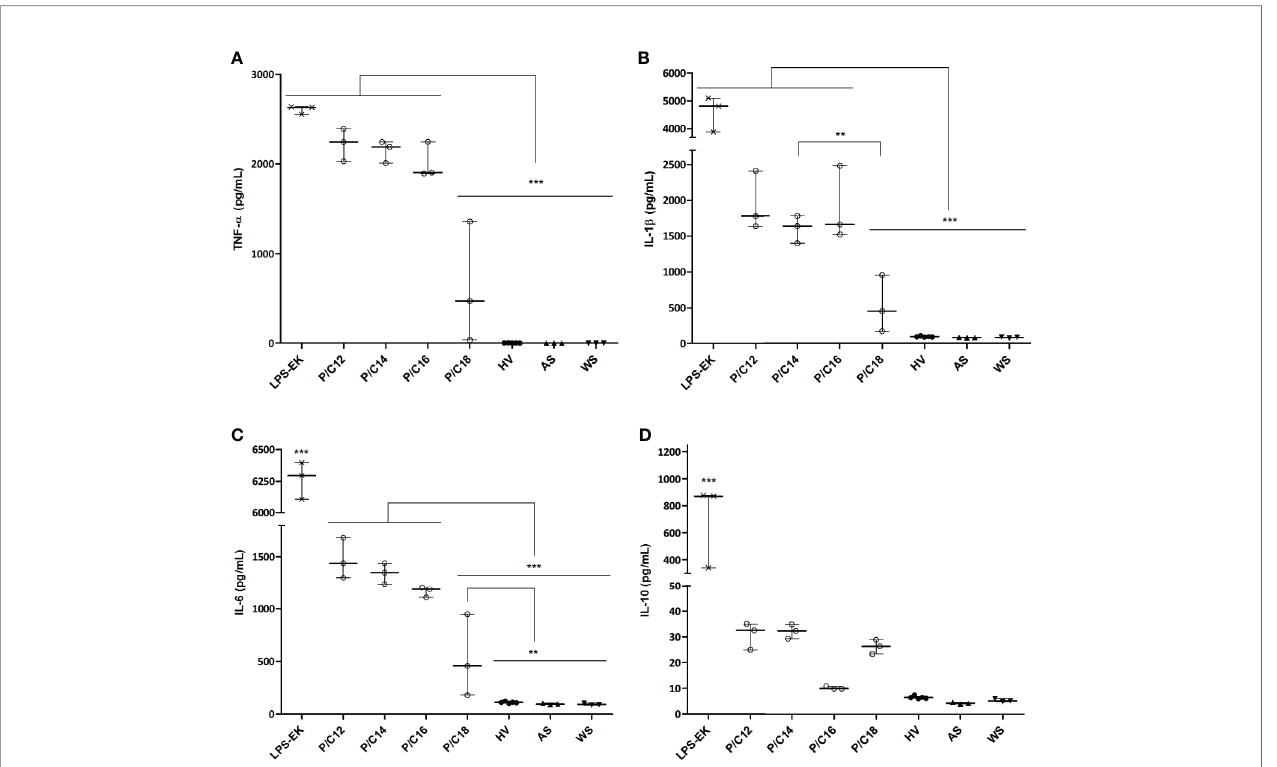
FIGURE 5 | Cytokine concentrations in supernatants of monocytes cultured with sera of end-stage renal disease (ESRD) patients (n = 12) according to the highest proportion of each LPS subtype and healthy volunteers (HV) (n = 5). Human monocytes were stimulated with ESRD patient ’ s serum according to the highest proportion of each LPS subtypes (P/C12, P/C14, P/C16, P/C18, n = 3 for each), with serum of HV (n = 5), with decomplemented autologous serum (AS, n = 3), with AS and LPS from E. coli (LPS-EK, 10ng/mL, n = 3) for the positive control, or monocytes cultured without serum (WS, n = 3) for the negative control. After 12 hours of stimulation, supernatants were collected and the secretion of cytokines TNF- a (A) , IL-1 b (B) , IL-6 (C) and IL-10 (D) were measured by enzyme-linked immunosorbent assay (ELISA). Bars and errors bars are expressed as median with interquartile range. Mann-Whitney U test of pairwise comparison values, ** p < 0.01, *** p < 0.001. IL, interleukin; LPS, lipopolysaccharide; TNF, tumor necrosis